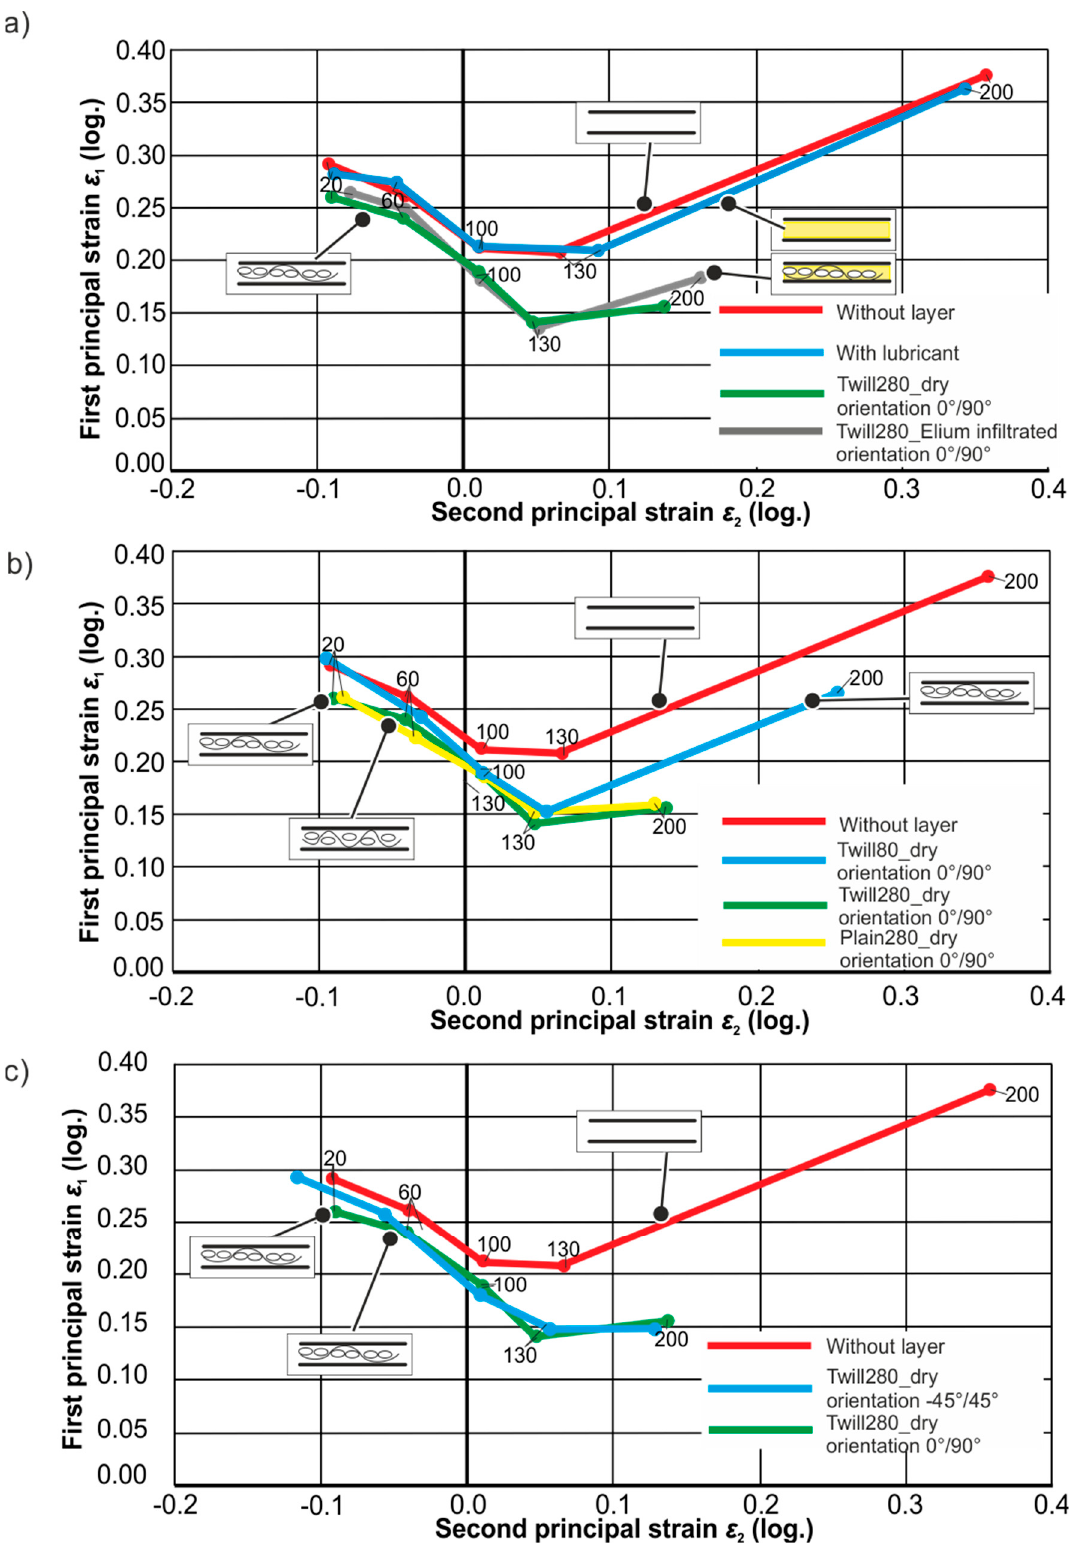
Figure 5. Forming limit curves (FLC) for different layups: ( a ) layup without layer compared with different layers and lubrications; ( b ) without layer compared with different fibers in 0° orientation; ( c ) without layer compared with Twill280 in two fiber orientations.